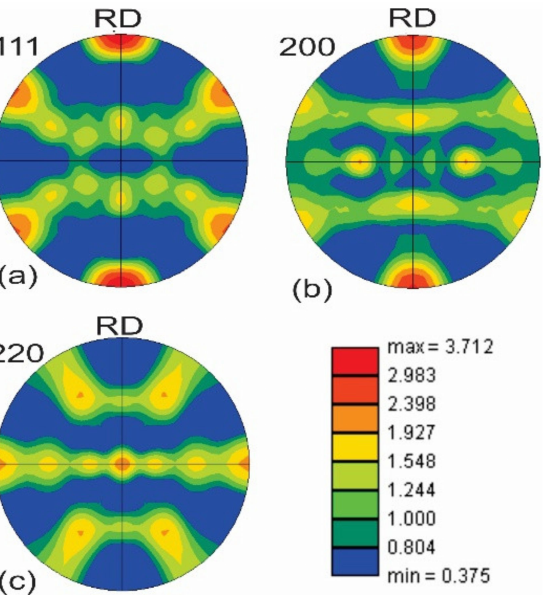
Figure 16. ( a ) { 111 } , ( b ) { 100 } , and ( c ) { 110 } PFs of the tubes drawn with − 5 ◦ tilted die after the second step of drawing at min. The maximum intensity of PFs is approximately